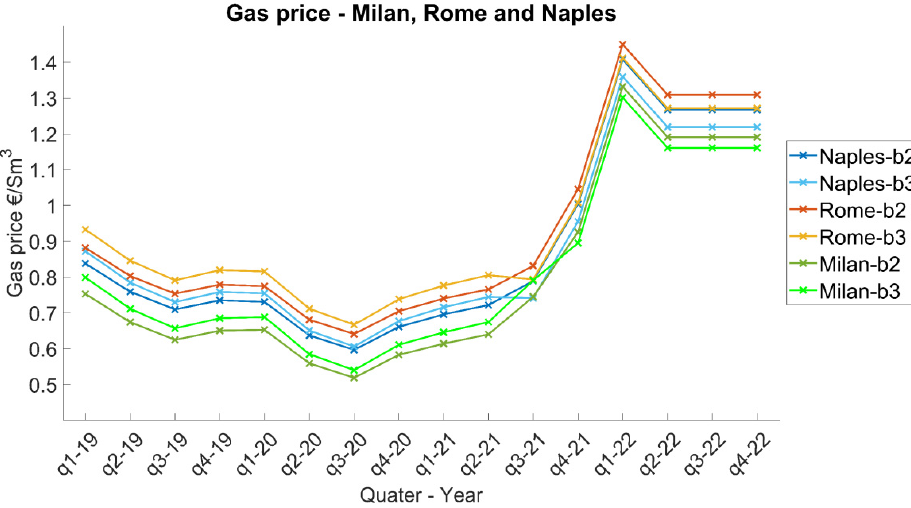
Figure 7. Unit gas prices (EUR/Sm 3 ) for Milan, Rome and Naples (2nd and 3rd consumption bands).